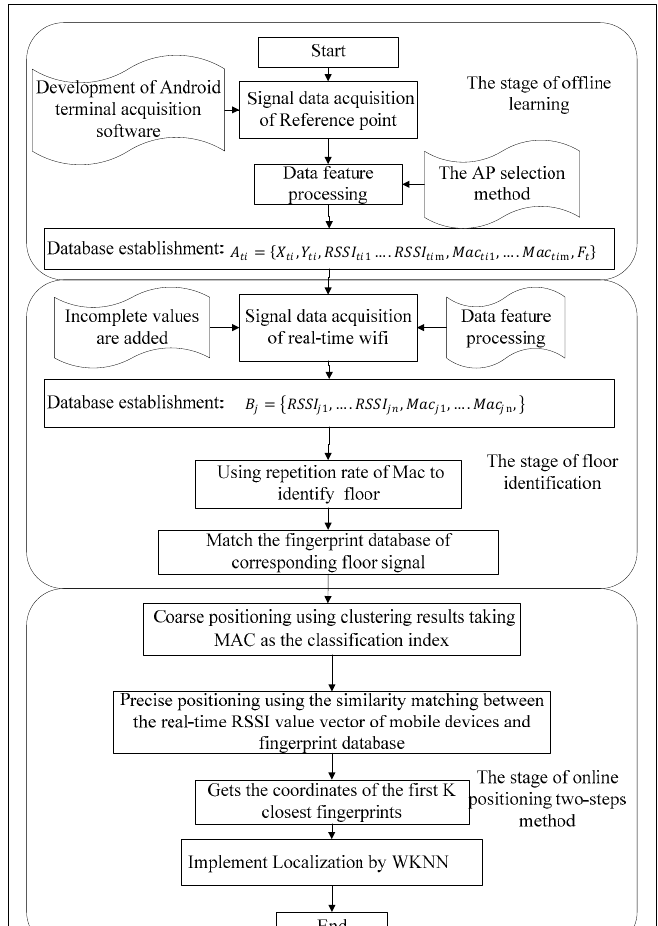
Figure 1. The proposed flowchart of indoor localization within multi-story buildings based on Wi-Fi.